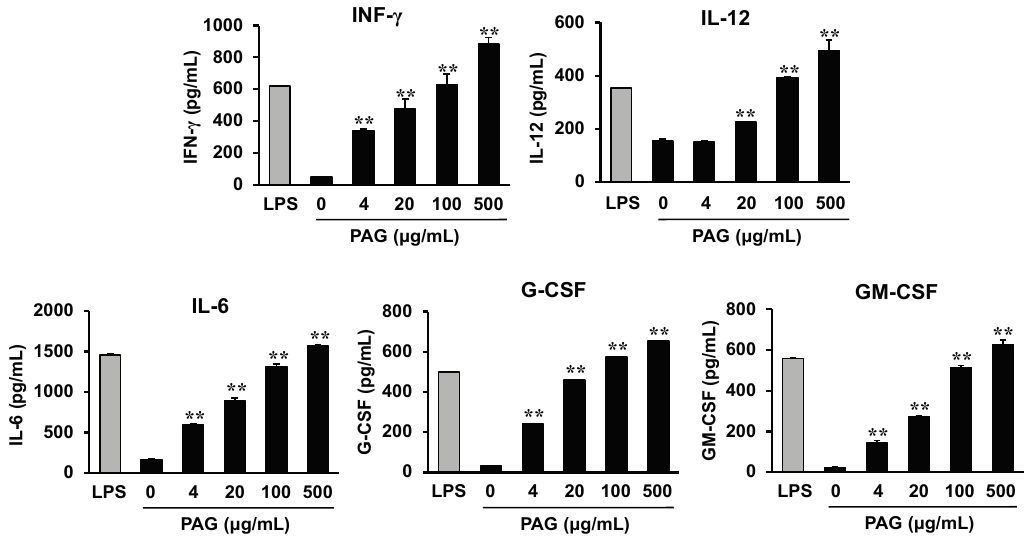
Figure 4. Aloe polysaccharides induce hematopoietic cytokine production by Peyer’s patch cells. Peyer’s patch cells isolated from control mice were stimulated with Aloe polysaccharides for 3 days. The cytokine levels in the culture supernatants were determined by using ELISA. ** indicates p < 0.01, compared to PAG-untreated